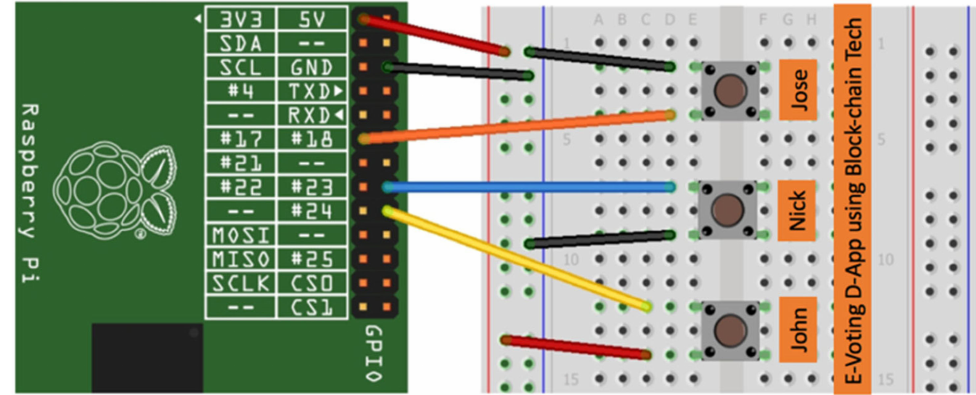
Figure 15. Hardware Diagram of IoTeD (Internet of Things embedded device) for the e-Voting D-App